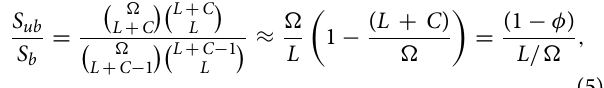
FIGURE 2 | Effects of molecular crowding on binding equilibria. (A) Probability for the receptor to be occupied, P b , as a function of the number of ligands for four different values of volume occupation, φ 0 . 5 . Crowding shifts the curves toward lower ligand concentrations. Simulation data are in agreement with Equation (6) (lines). (Inset)